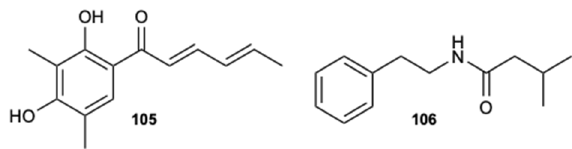
(cid:48) -phenelethyl)-butyrylamide ( 106